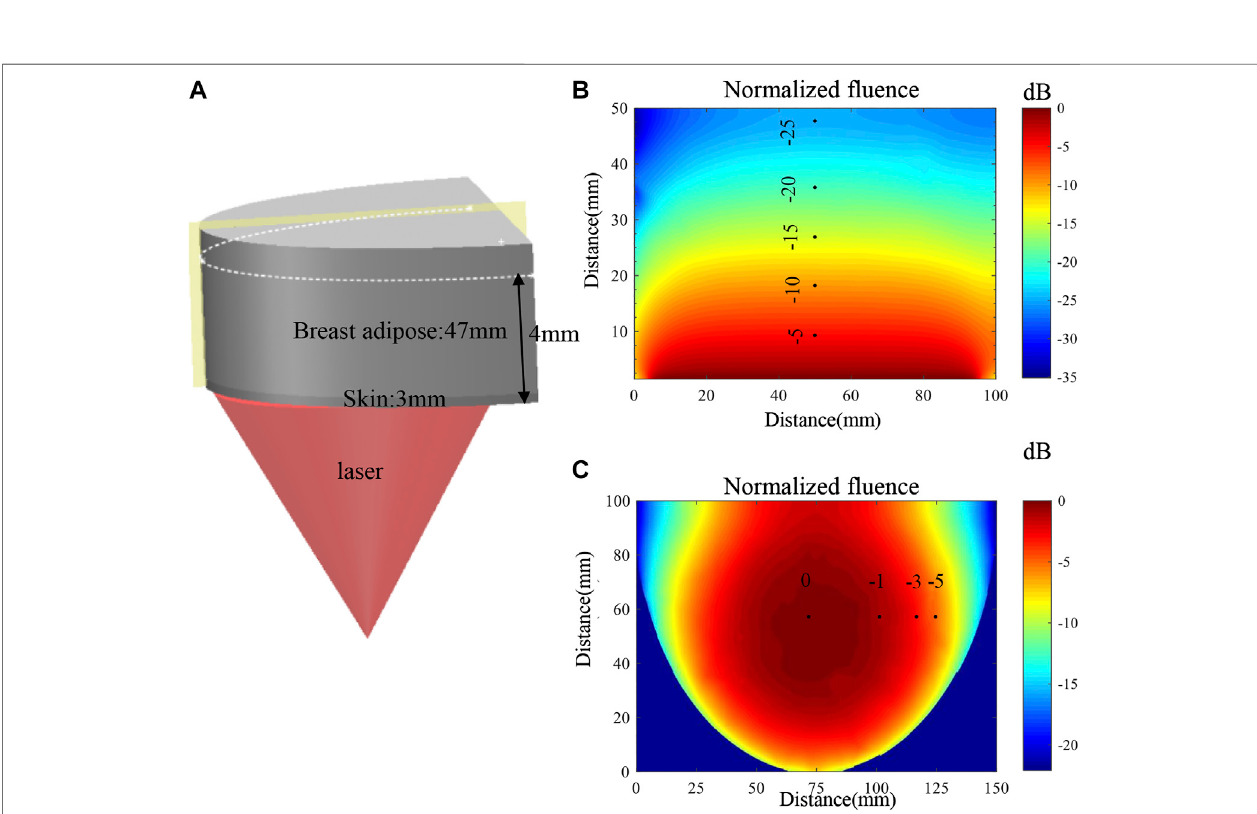
Figure 4B . Figure 4C presents the calculated normalized optical fl uence distributions over a horizontal plane (marked as a white dashed line in Figure 4A , 4 cm from the illuminated bottom surface. The color bar scale of all the fl uences is in dB scale. The simulation results implicit that the light fl uence could be decreased to two orders less after penetrating 4 cm in the breast, which will de fi nitely in fl uence the reconstructed PA values. Therefore, fl uence compensation algorithms are desired, and we will demonstrate it in the phantom study.